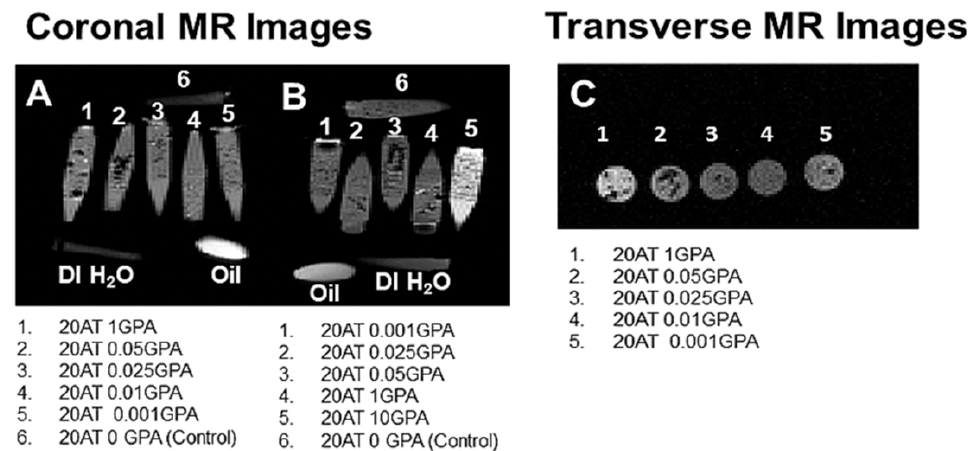
Figure 5. MR images using T 1 -weighted parameters (TE = 30 msec, TR = 500 msec) are shown: ( A , B ) Coronal MR images of compositions as labelled with oil and water controls; ( C ) Transverse MR images of compositions as labelled.